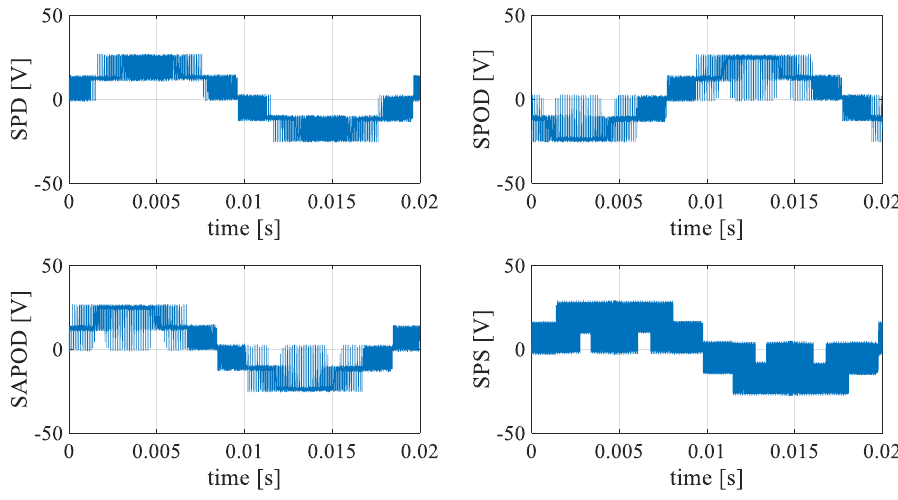
Figure 11. Line voltage waveforms acquired with a modulation index equal to 0.5.